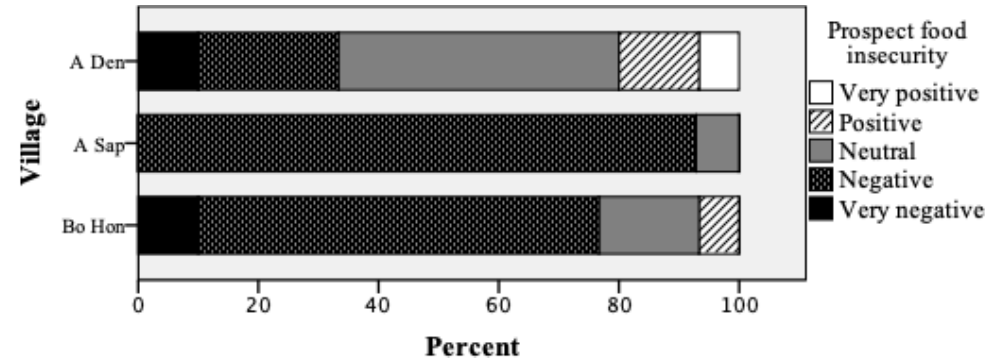
Figure 9. Evaluation of the future of local food